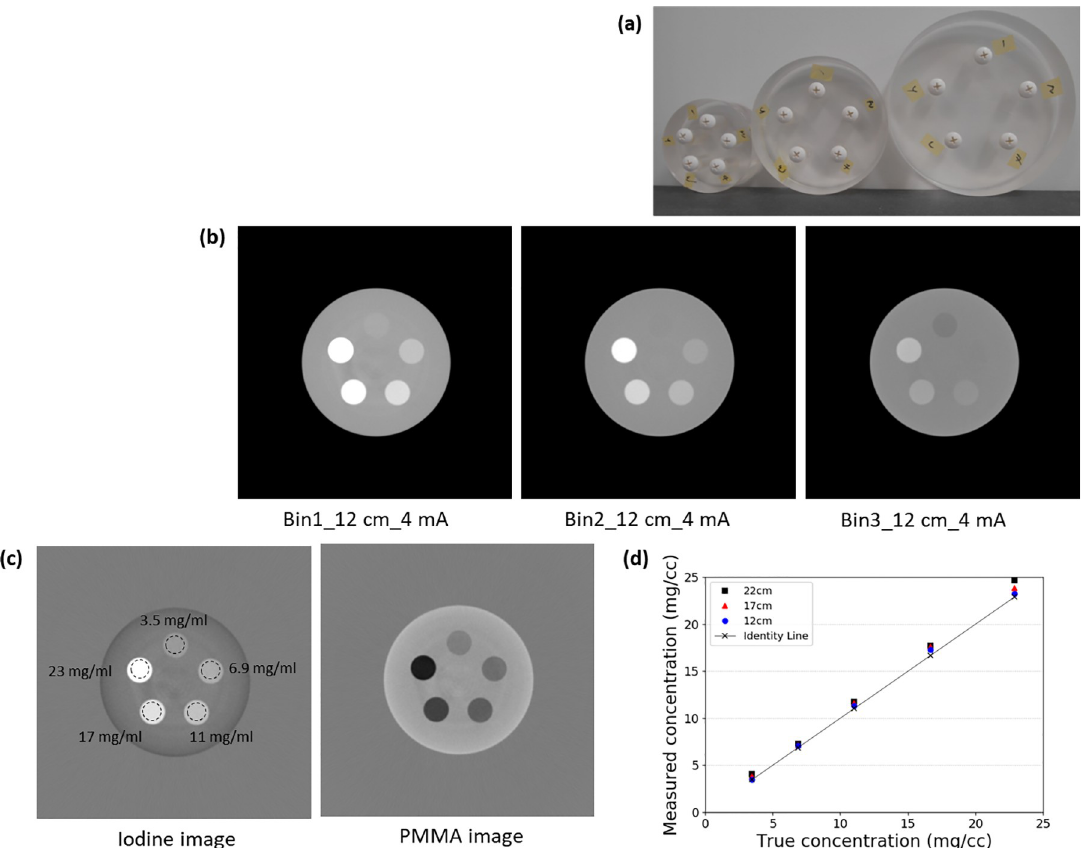
Fig 2. (a) Three different cylindrical phantoms (diameter: 12, 17, and 22 cm) for iodine quantification accuracy. (b) Low-energy threshold (bin 1: 30–50 keV), middle-energy threshold (bin 2: 50–65 keV), and high-energy threshold (bin 3: 65–140 keV) images of the 12 cm phantom. (c) Iodine images and PMMA images. (d) Comparison of the measured iodine concentration with the true concentration.